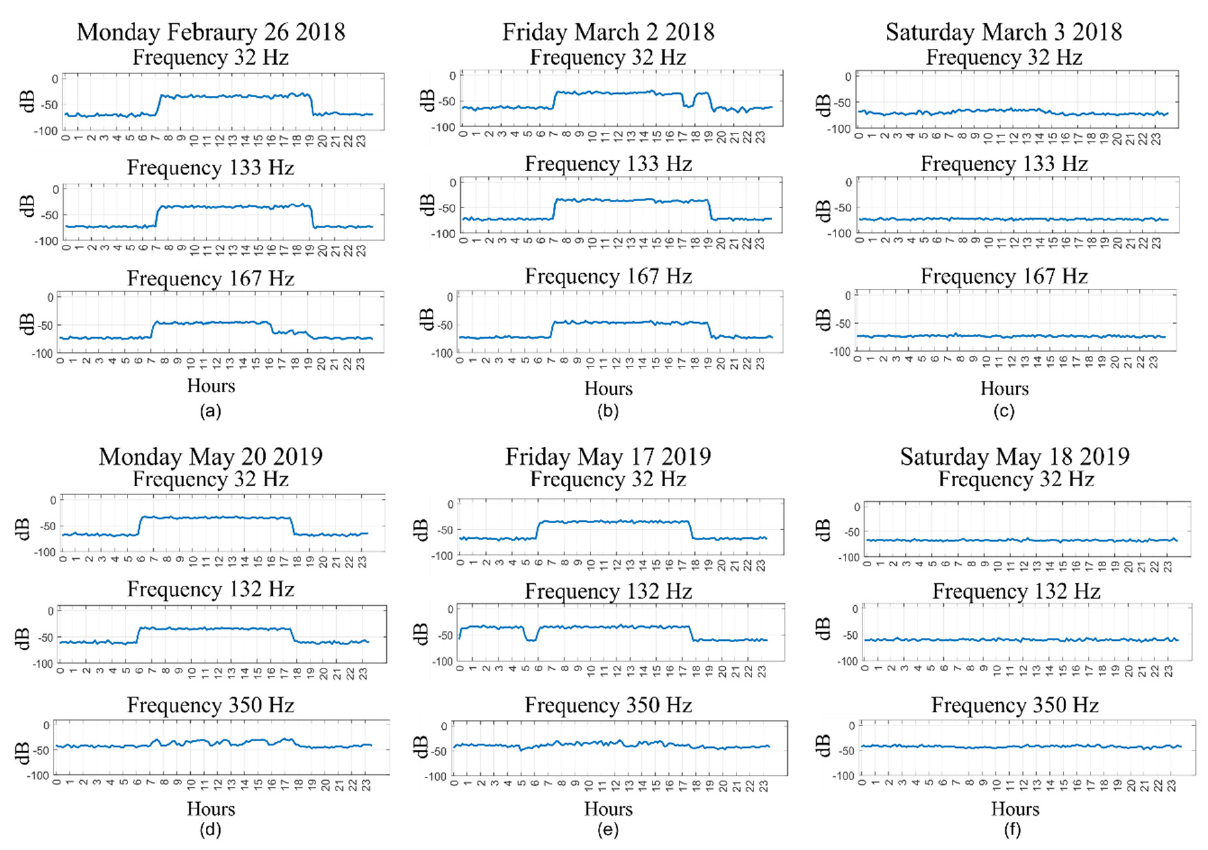
Figure 7. SFC for the current signals: ( a ) frequencies 32 Hz, 133 Hz and 167 Hz for Monday 26 February 2018, ( b ) frequencies 32 Hz, 133 Hz and 167 Hz for Friday 2 March 2018, ( c ) frequencies 32 Hz, 133 Hz and 167 Hz for Saturday 3 March 2018, ( d ) frequencies 32 Hz, 132 Hz, and 350 Hz for Monday 20 May 2019, ( e ) frequencies 32 Hz, 132 Hz, and 350 Hz for Friday 17 May 2019, and ( f ) frequencies 32 Hz, 132 Hz, and 350 Hz for Saturday 18 May 2019.